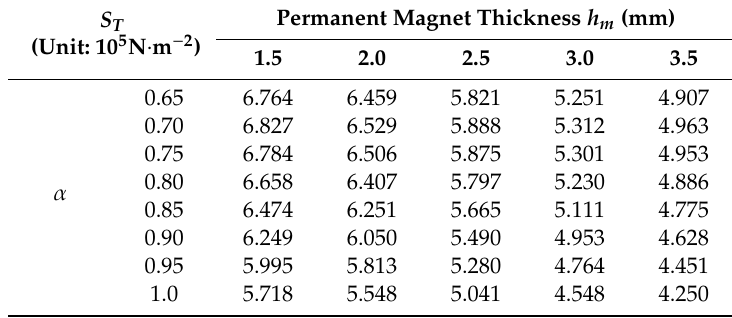
Table 3. S T of 40